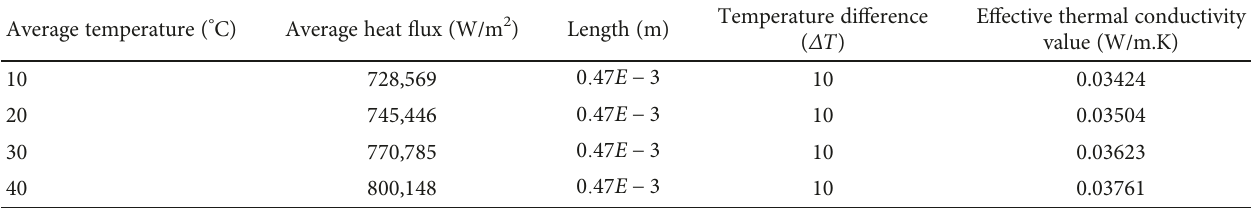
Table 4: The numerical solution results for the expanded polystyrene with the density value of 16kg/m 3 . Average temperature ( ° C)